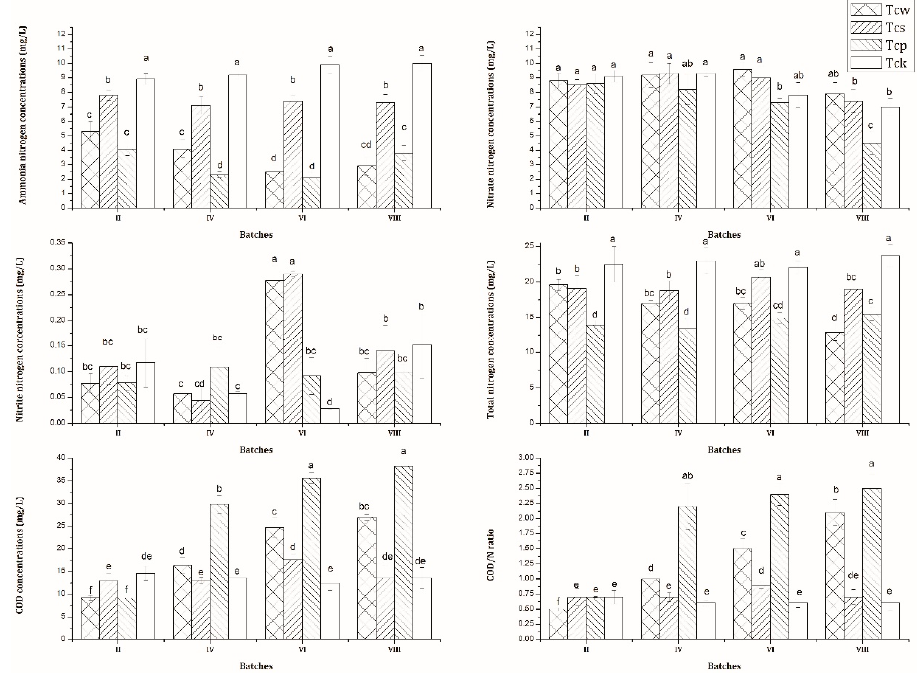
Figure 1. Concentrations (mg · L − 1 ) of NH 4 + –N, NO 3 − –N, NO 2 − –N, TN, and COD as well as the COD/N ratio ( n = 4) Different letters indicate significant differences ( p < 0.05) among the different systems.